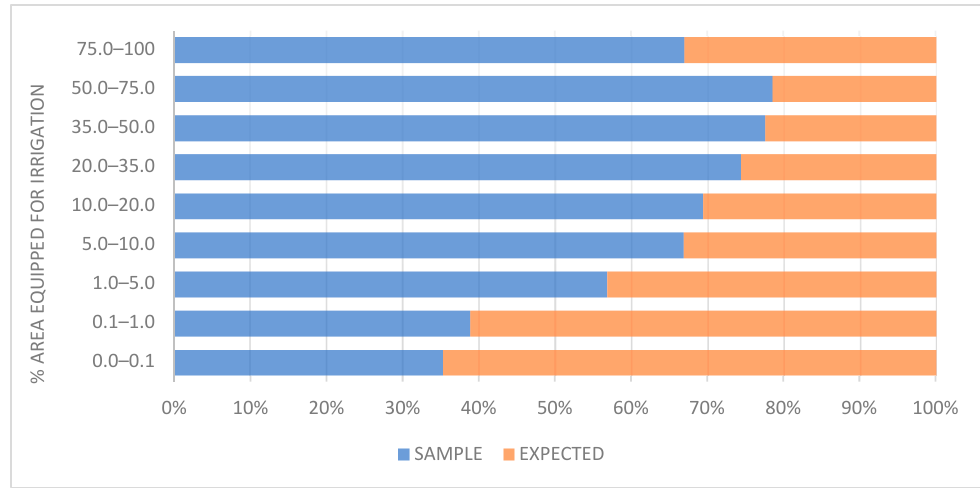
Figure 8. Percentage of Observed (~Sample) vs. Expected Counts for Irrigation Variable.